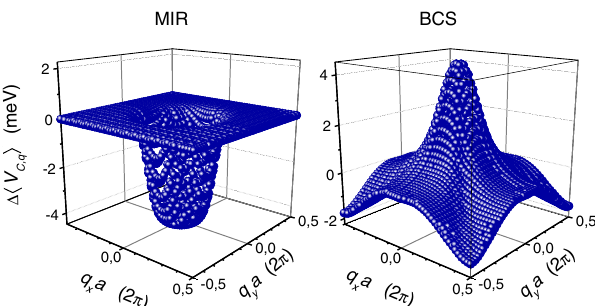
FIG. 1. S – N difference of the partial Coulomb energy E C q . Left panel: According to the MIR scenario (schematic). Right panel: Resulting from a BCS model calculation [15] for d -wave symmetry, p ¼ 0 . 16 hole doping, and the interaction 100 K. Both panels represent the adjusted such as to give T c ¼ 0 cut in momentum space, corresponding to the electric q z ¼ field polarized along the planes. E C q at q ¼ 0 corresponds to the integral [Eq. (1)] of the optical in-plane loss